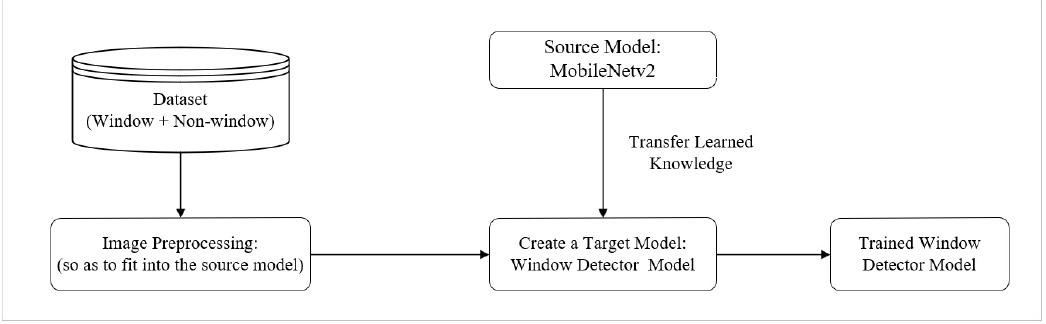
Figure 7. Creation a window-object detector using transfer